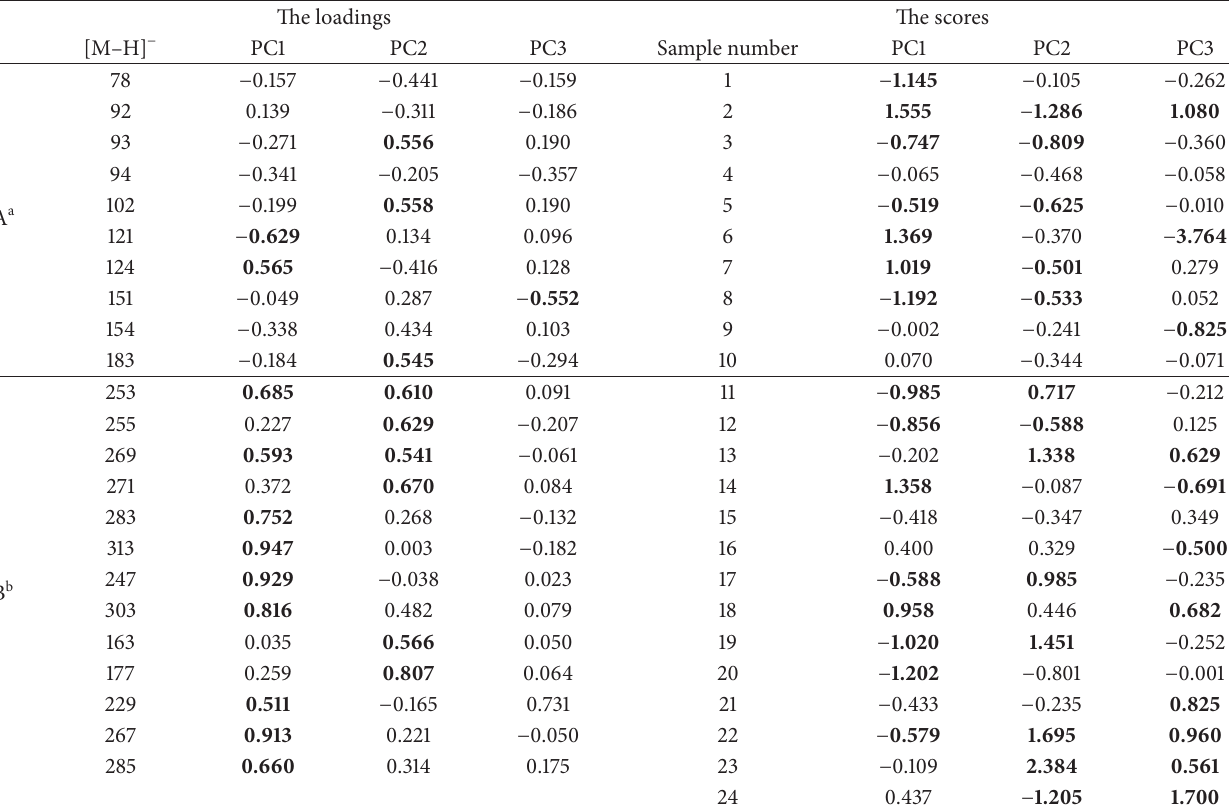
Table 2: The loadings and scores for the first three rotated principal components. The